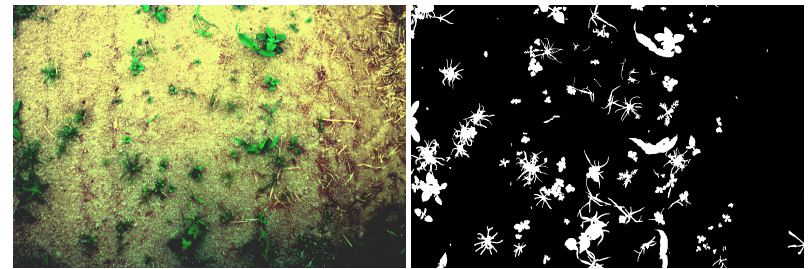
Figure 2. False color in the left and corresponding manual ground truth on the